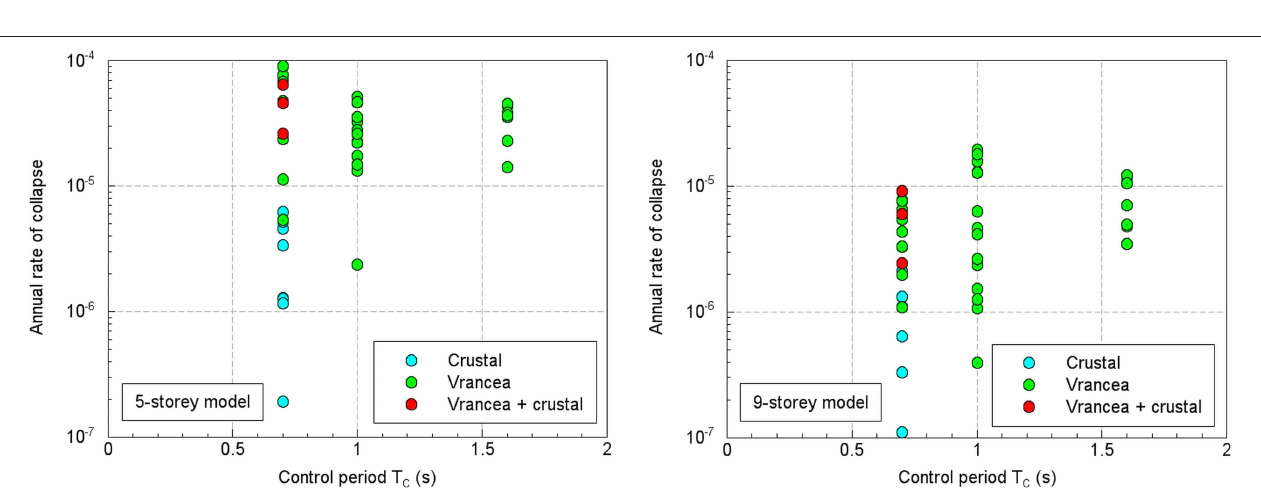
FIGURE 5 | Comparison of annual rate of collapse for the five-story model (Left) and nine-story model (Right) as a function of the control period T C .